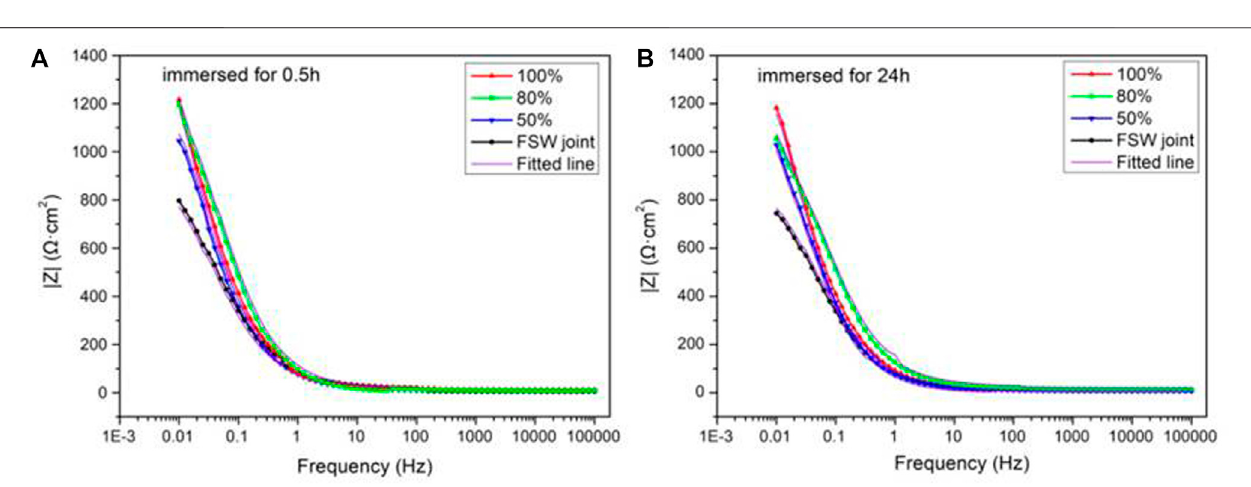
FIGURE 8 | Bode plots of FSW joint and Ni coatings immersed for 0.5 h (A) and 24 h (B) in simulated seawater.